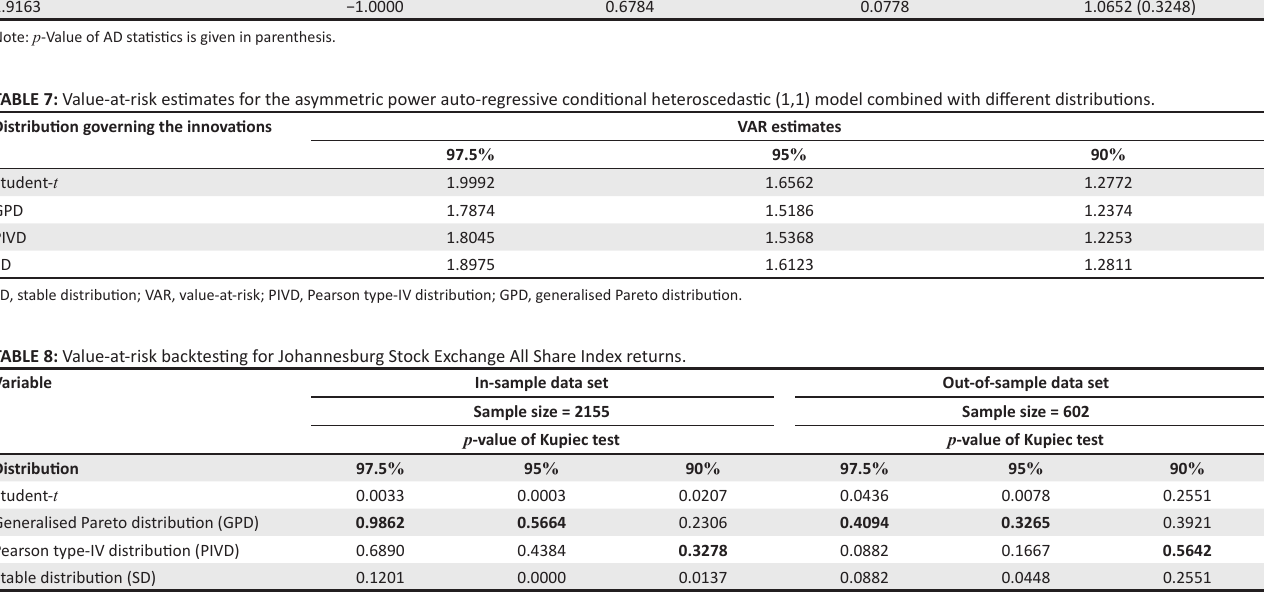
TABLE 6: Maximum likelihood estimates of the stable distribution for the asymmetric power auto-regressive conditional heteroscedastic (1,1)–stable distribution model. αα ˆ